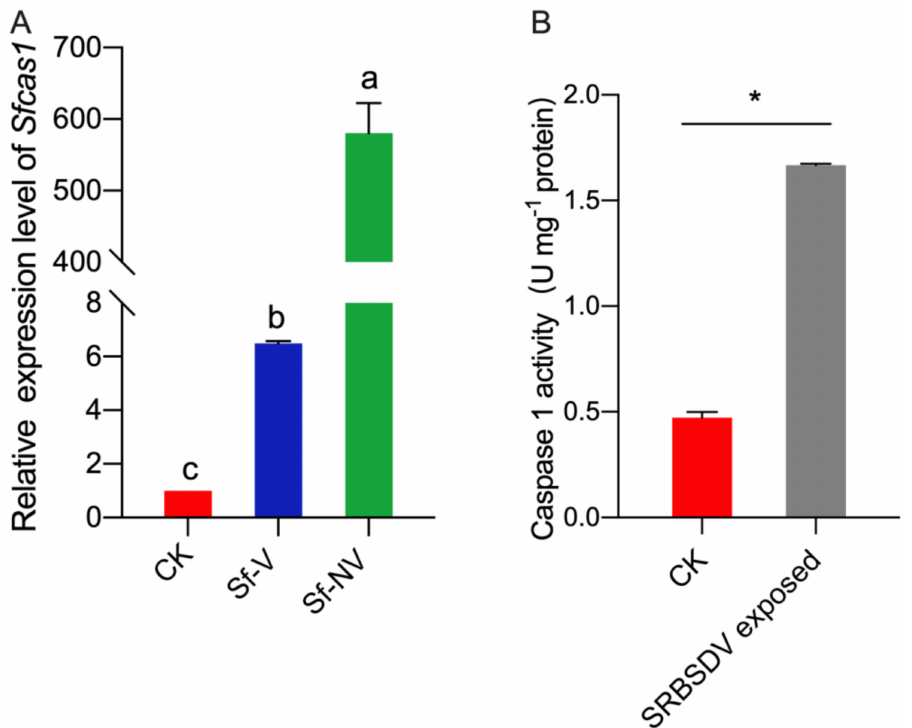
Figure 5. The Sfcas1 expression level and caspase 1 activity in S. furcifera : ( A ) expression of Sfcas1 in S. furcifera females acquired SRBSDV or not: Sf–V, S. furcifera females acquired SRBSDV; Sf–NV, S. furcifera females failed to acquire SRBSDV; CK, S. furcifera females exposed to healthy rice plants. Expression was normalized to the level of SfEF1 α that serves as the internal standard. The relative mRNA level of Sfcas1 in S. furcifera fed on healthy rice plants (CK) was arbitrarily set to 1. Different letters over the bars (mean ± S.E.) indicate significant differences (Duncan test, p < 0.05); ( B ) caspase 1 activity in S. furcifera exposed to SRBSDV infected rice or not. “*” indicates significant difference ( t test, p < 0.01).